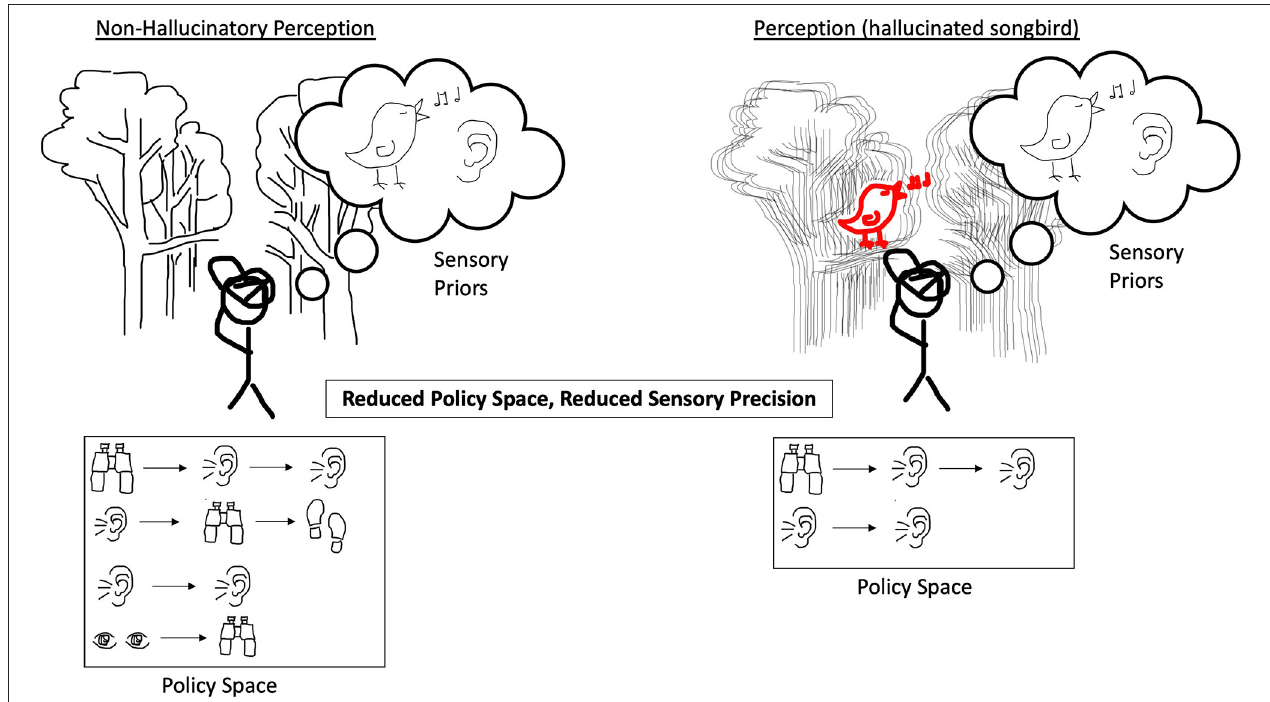
FIGURE 3 | On the left, the agent experiences incoming sensory evidence to which it ascribes low confidence, and it has equally weighted priors and policies in an expansive policy space. The result is an agent that does not hallucinate. On the right, the agent experiences degraded precision of incoming sensory evidence and a decreased policy space. The decreased policy space now only includes a couple of policies that rely heavily on listening. The result is an agent that does not have a full range of policies adaptable to the world it finds itself in and which imply that a singing bird is present and thus the agent hallucinates the